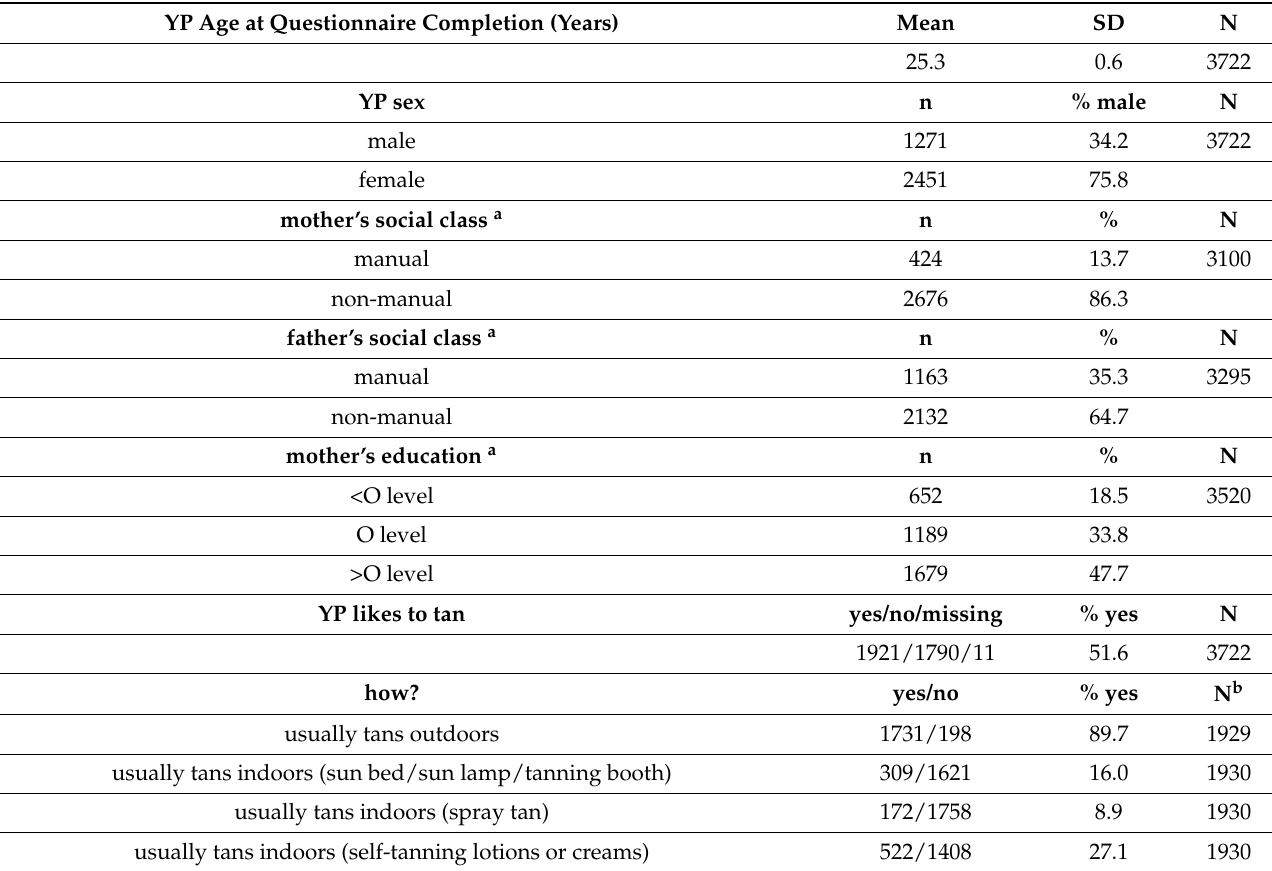
Table 1. Characteristics of ALSPAC young people (YP) who completed the questionnaire Life@25+, Tanning and Sun Exposure